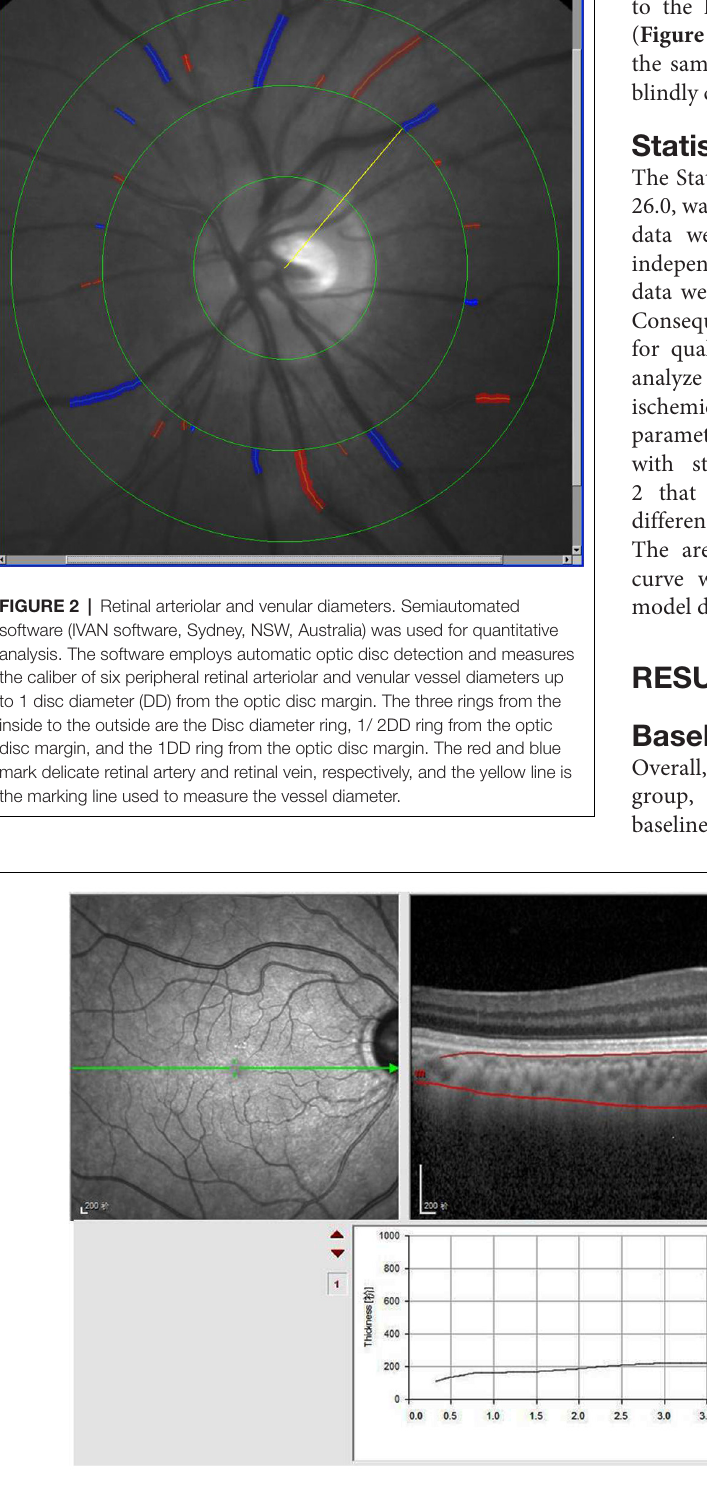
Frontiers in Aging Neuroscience |